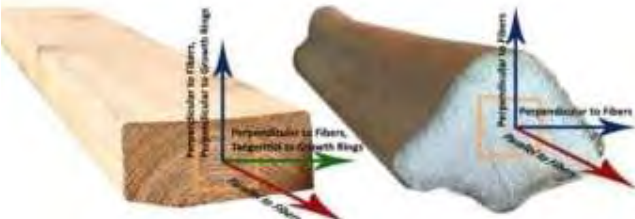
Figure 14. Axes of material in Timber and Date Palm Rachis (Yasser et al., 2017)